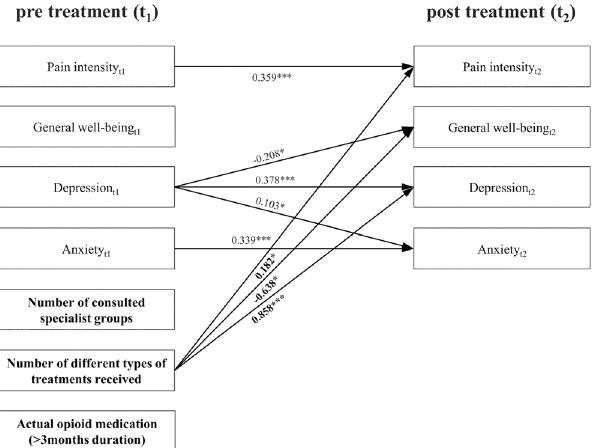
Fig 4. Path diagram of associations between pre-admission healthcare utilization, pre-treatment pain intensity, general well-being, depression, anxiety and post-treatment measures. Unstandardized regression coefficients, * p < 0.05, ** p < 0.01, *** p < 0.001; non-significant associations and covariance are not